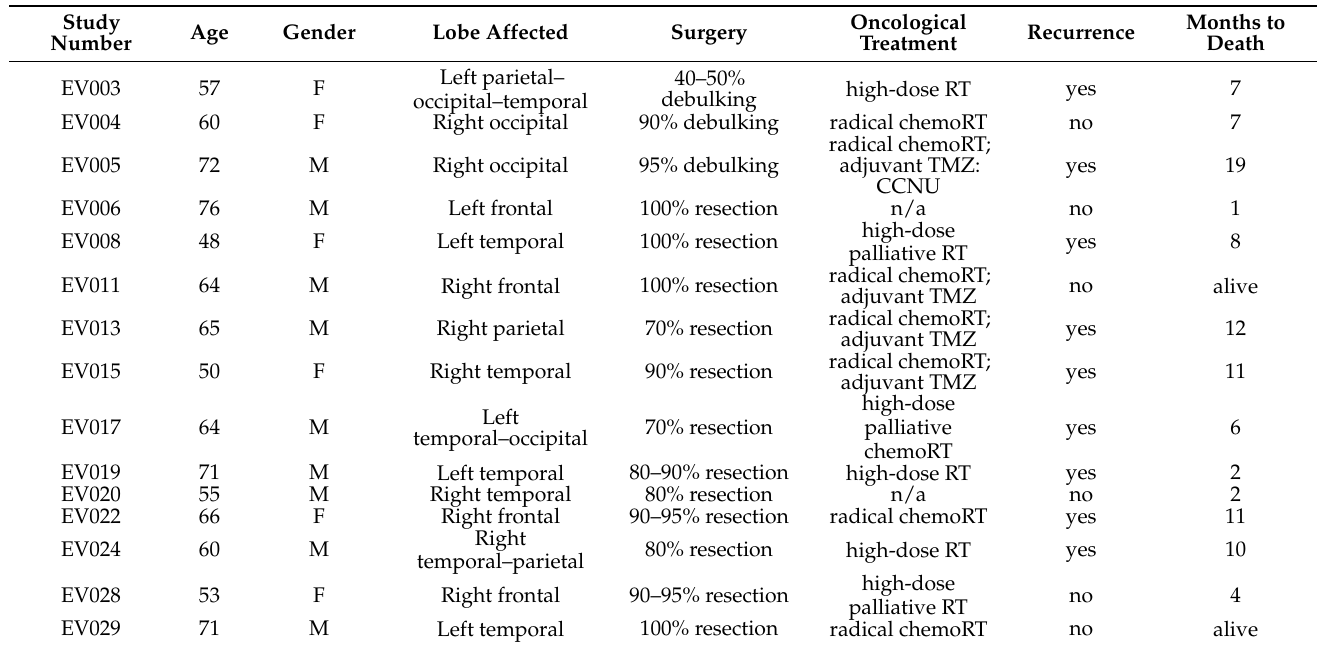
Table 1. GB patients’ clinical